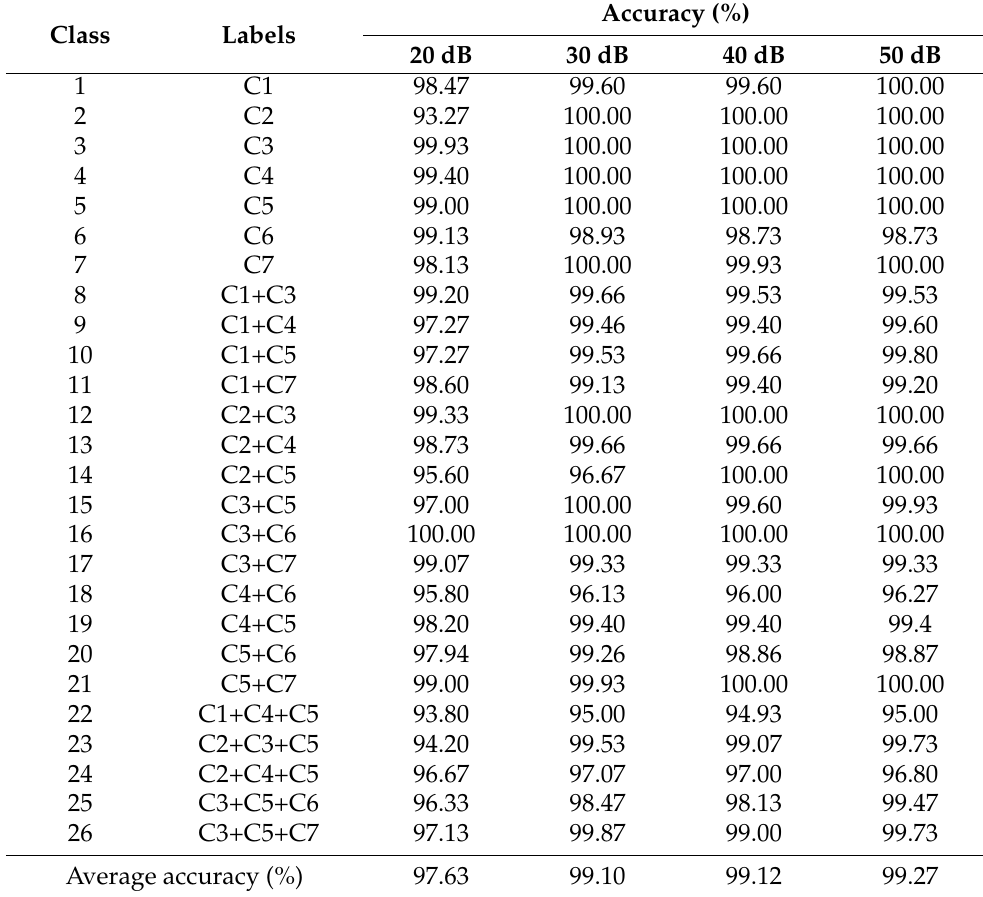
Table 1. Classification accuracy of the proposed method at different noisy levels for synthetic data.